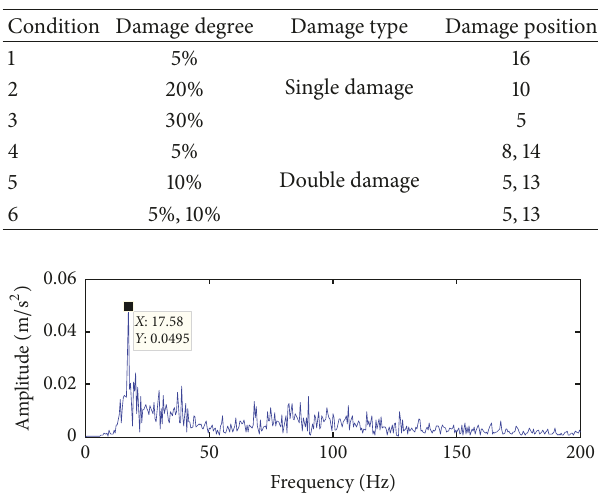
Figure 2: Spectral analysis of the acceleration response of node 15 in the derrick steel